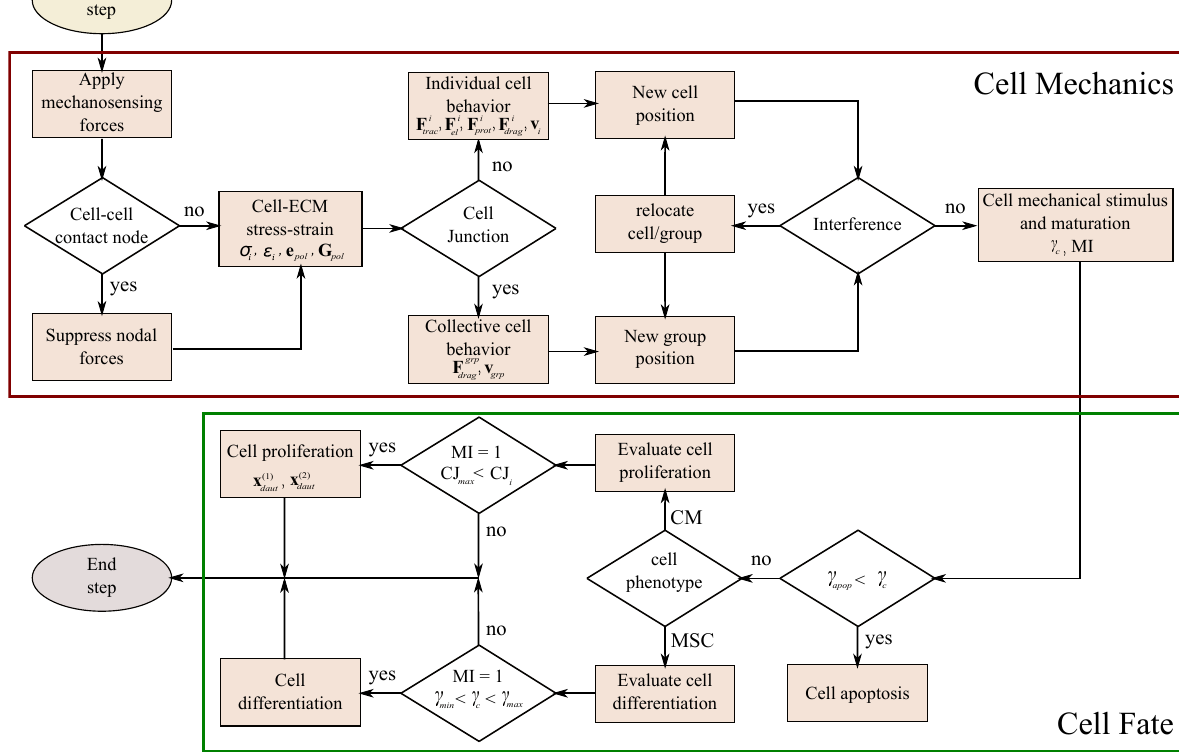
ECM interface. All the different cell processes are evaluated at each time step, as described in Figure 5. Each time step considers 1 h of cell–ECM interaction. The necessary model parameters are detailed in Table 1.